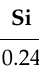
Figure 2. The initial microstructure of the studied cold-rolled steel consisting of a ferritic matrix with martensite islands and pearlite seen in ( a ) optical microscopy (OM) and ( b ) SEM. 3. Results and Discussion 3.1. Microstructure Comparison The microstructure of both samples was observed with optical microscopy (OM) and SEM. From OM images (Figure 3a,b), it is seen that both CH and UFH samples consist of martensitic islands and undissolved cementite embedded into ferritic matrix. The pearlitic colonies in the UFH sample (Figure 3b) appear to remain unaffected by the heat treatment and retain their cold-rolled banded morphology from the initial microstructure (Figure 2a). The ferrite grains are more equiaxed in the CH sample, while in the UFH sample they appear to retain the shape of the cold-rolled microstructure. SEM images (Figure 3c,d) show that the microstructure appears more refined in the UFH (as discussed later in this paper) while the disintegration of pearlite is not as pronounced as in the CH sample, since cementite is present in the lamellar and spheroidized forms.